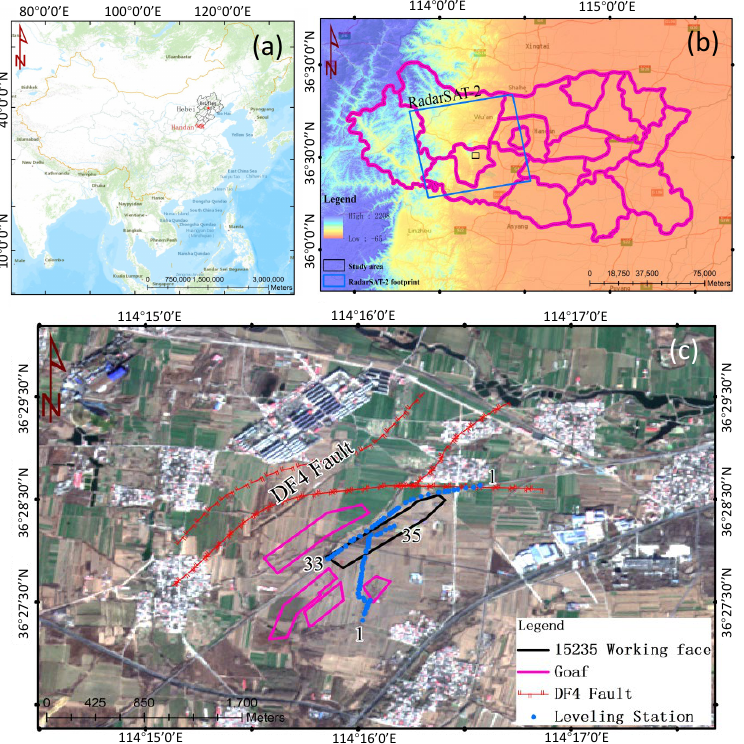
Figure 3. Study area overview: ( a ) shows the location of the study area. ( b ) shows the coverage of RADARSAT-2 images and the altitude of the study area. ( c ) shows the goafs, working faces, faults, and leveling stations. The numbers around the blue points indicate the name of the leveling